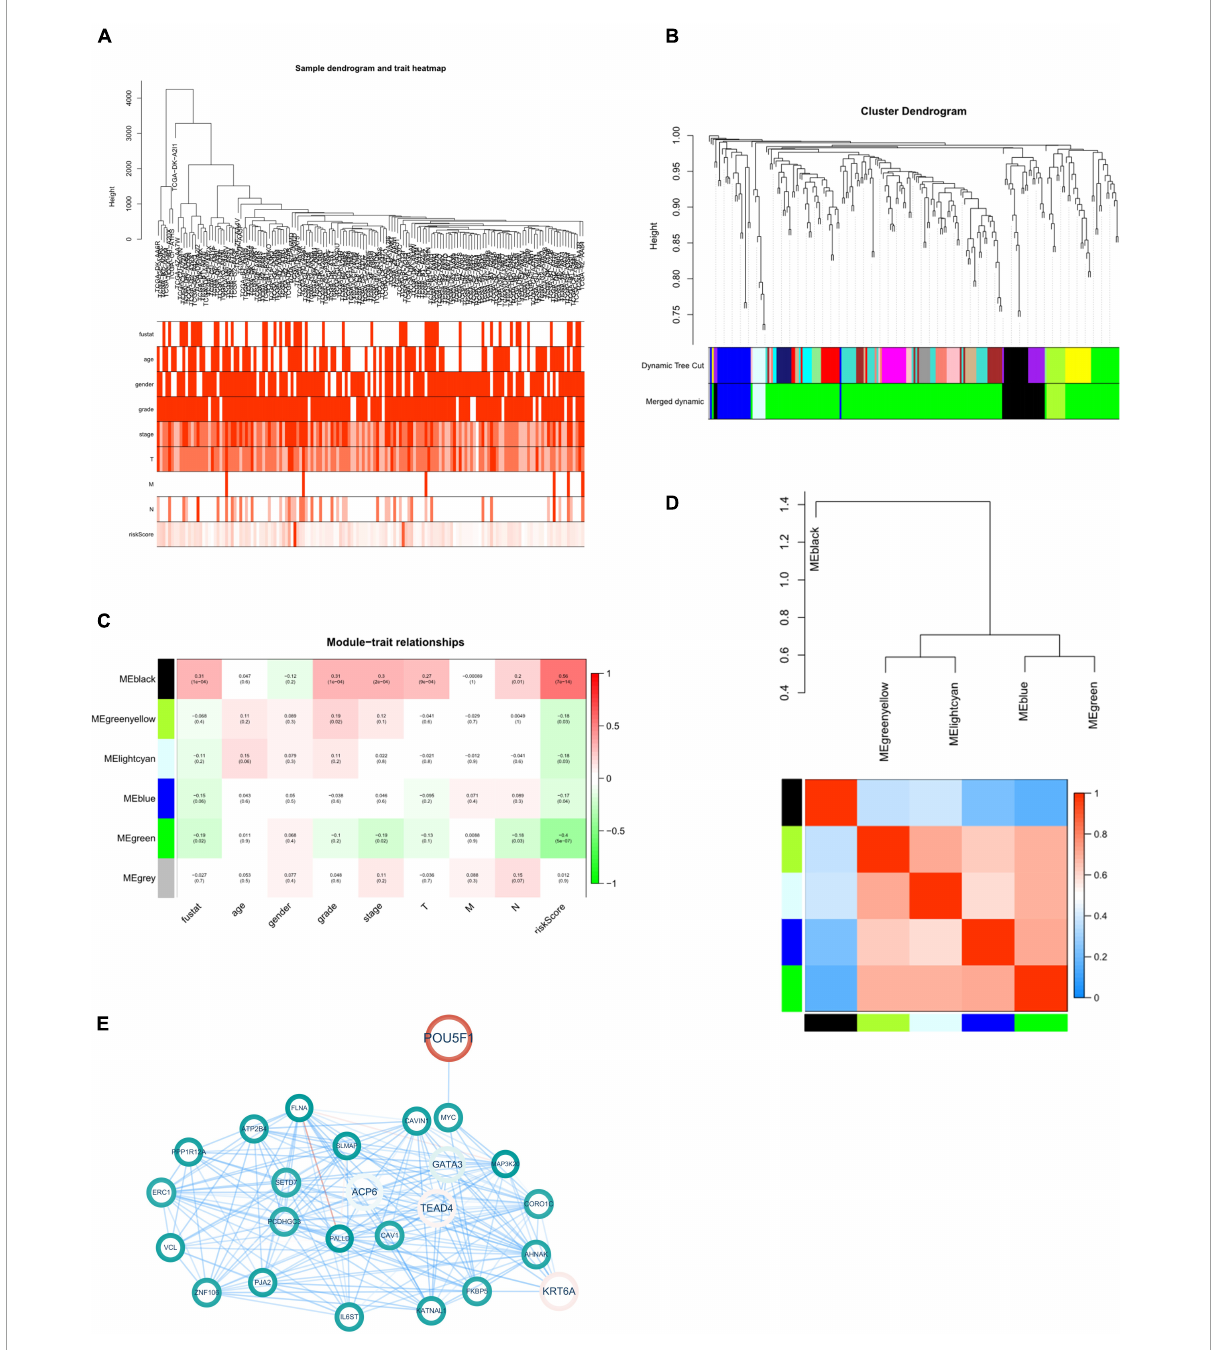
FIGURE5 WGCNA of eRNAs-related genes. (A) Clustering dendrogram with clinical traits heatmap. (B) Identification of co-expressed modules. (C) Module-trait heatmap. (D) Interaction between co-expressed modules. The blue to red spectrum represents an increase in relevance. (E) Black module gene-based regulatory network. The red and blue lines represent positive and negative correlation, respectively. Color transparency and size of node were defined with gene expression level. p < 0.05 was considered statistically significant.